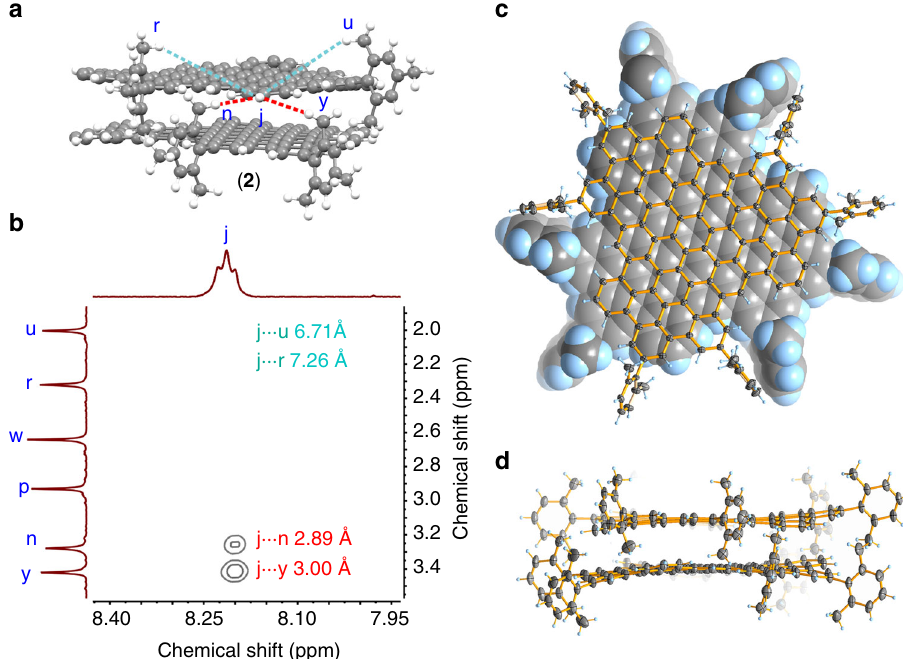
Fig. 3 H···H proximity in 2 and crystal structure of 2 ’ . a Typical H···H proximity found in 2 . The interlayer and intralayer H···H proximity are represented as red and cyan dashed lines, respectively. The rest mesityl groups are omitted for clarity. b Expanded two-dimensional nuclear overhauser effect spectroscopy of 2 , showing interlayer proton coupling. The detailed H···H distances are labeled inside. b . c Top view of the crystal structure of 2 ’ . For clarity, one layer is illustrated with the space fi ll model and the other layer with the ellipsoid model. d Side view of the crystal structure of 2 ’ . The thermal ellipsoids are set at 50% probability level